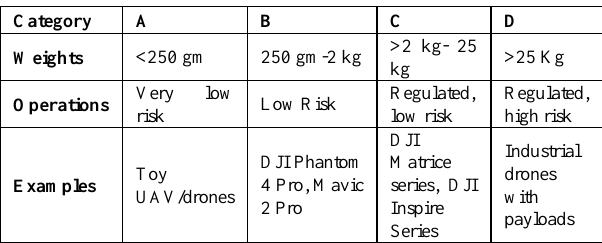
Table 2. Categorization of UAV based on